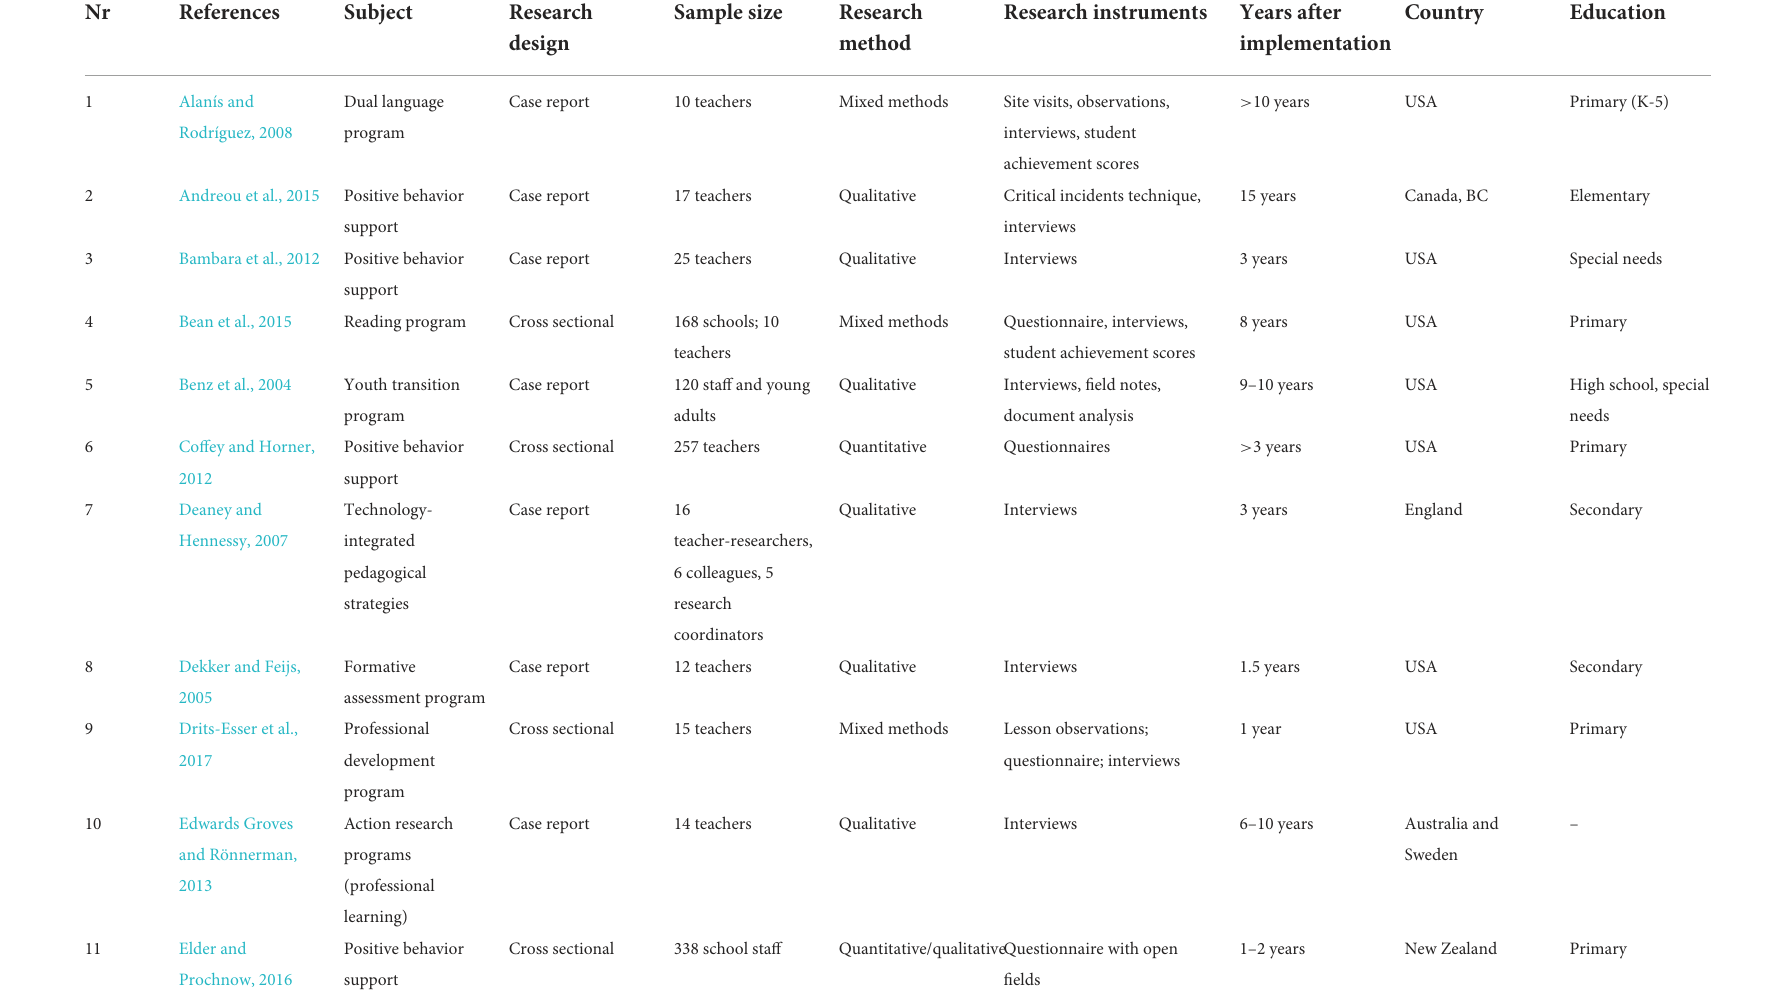
TABLE 1 Characteristics of included studies for the systematic